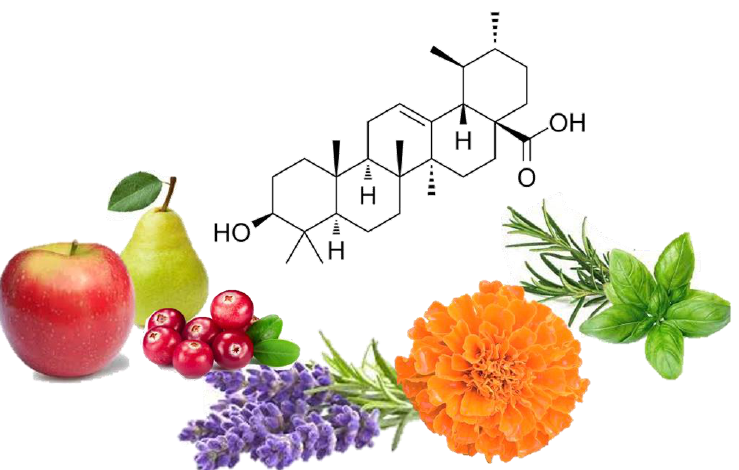
Figure 1. Chemical structure of ursolic acid, a compound present in the leaves and flowers of many plants, including lavender and marigold; fruits, such as apples, cranberries and pears; and herbs, including basil and rosemary. including basil and